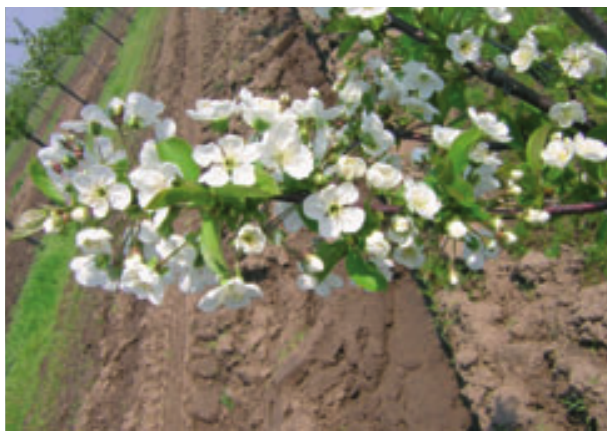
Figure 6. Profusely blooming branch of the variety ’Gerema’ ( Debrecen- Pallag, 2010)